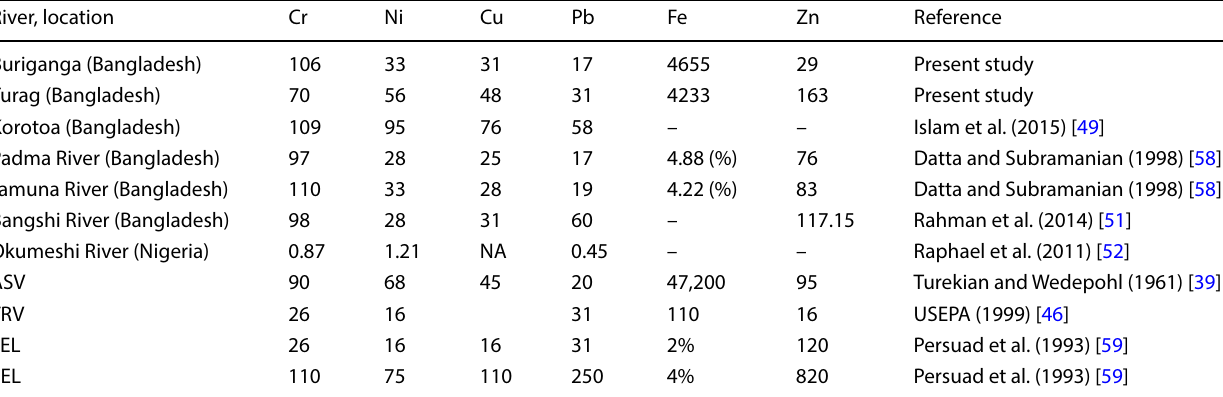
Table 5 Comparison of metals in sediment (mg/kg) with different international guidelines and other studies in the world